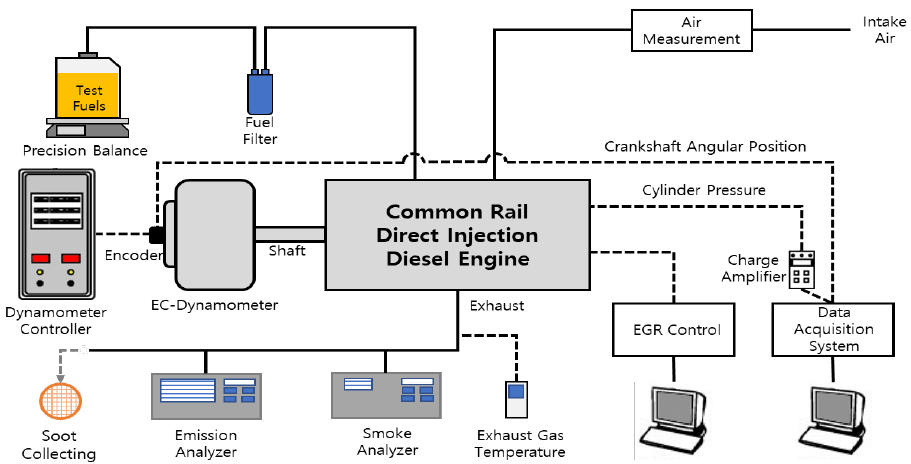
Figure 2. Schematic diagram of the experimental setups.